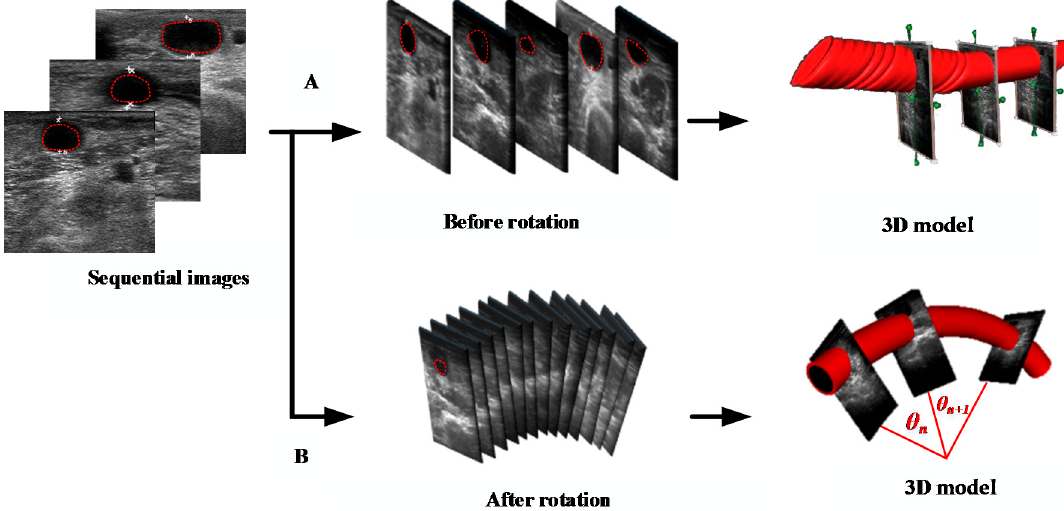
Figure 7. Reconstructed 3D images of the fistula ( A ) before and ( B ) after rotation.